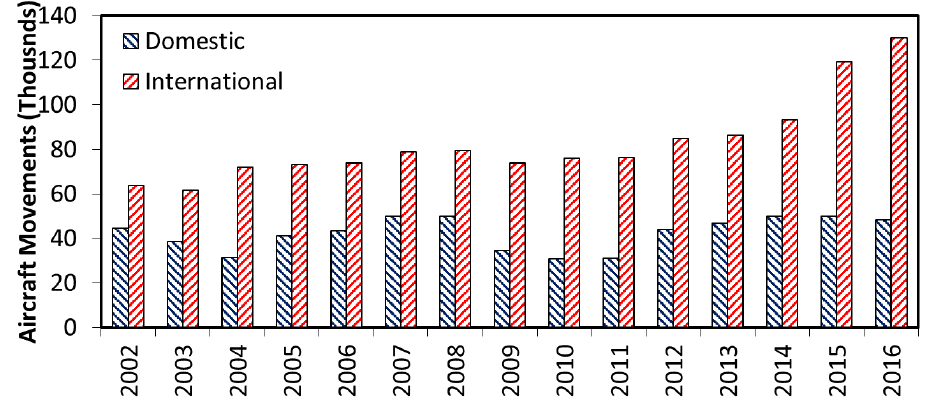
Figure 1. The annual domestic and international passenger traffic at KIX: 2002 to 2015. Source: data derived from Reference [61].